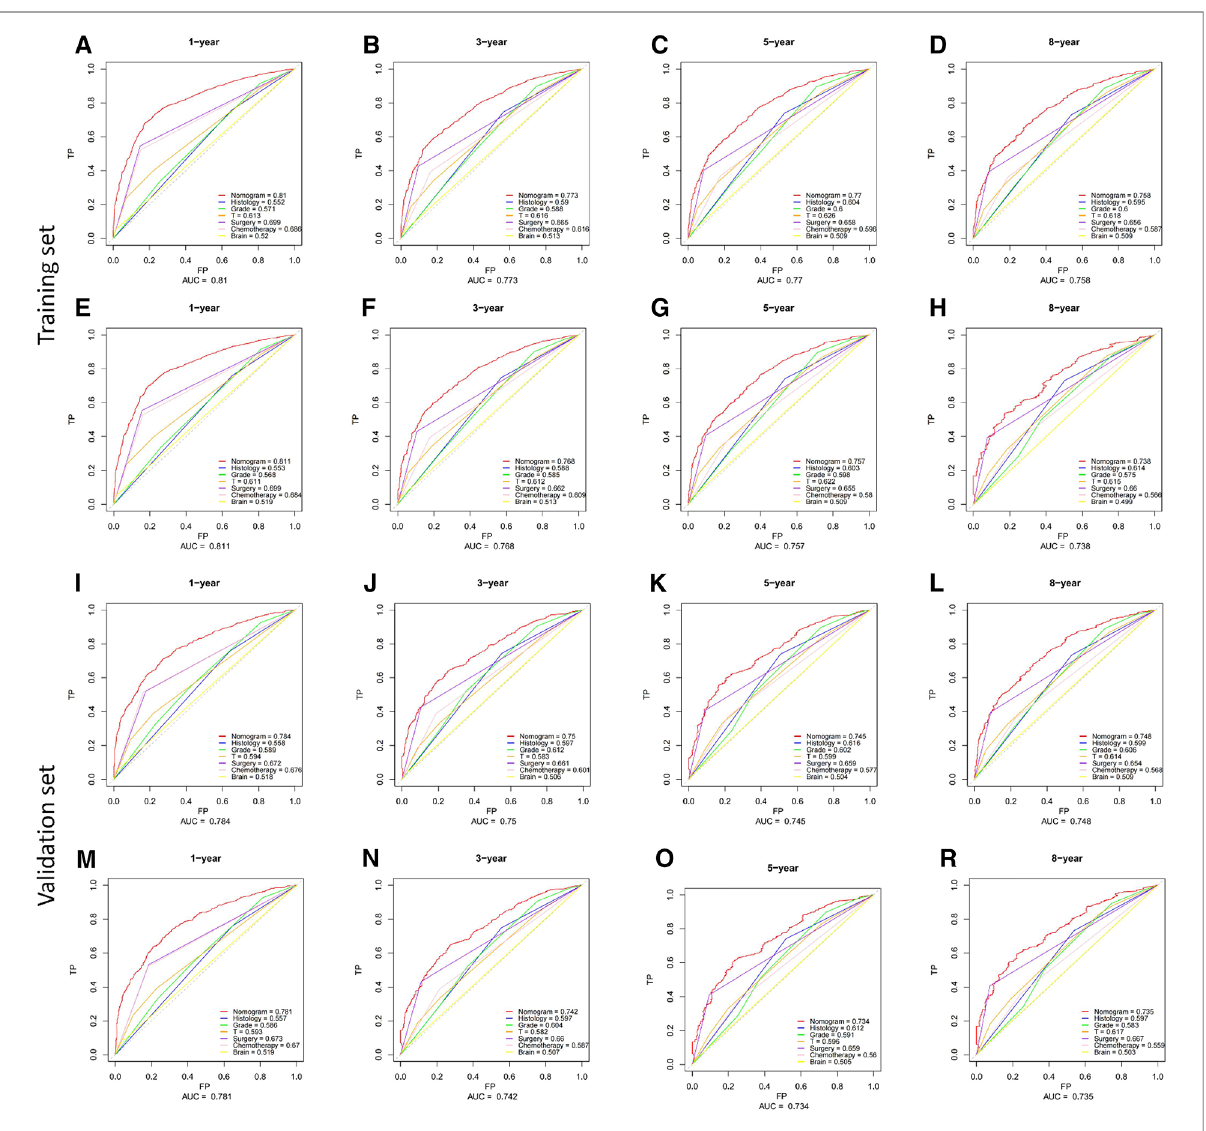
FIGURE 3 ROC curves of the nomograms for predicting CSS and OS at 1-,3-,5- and 8-year point. ( A – H ) the training cohort; ( I – P ) the validation